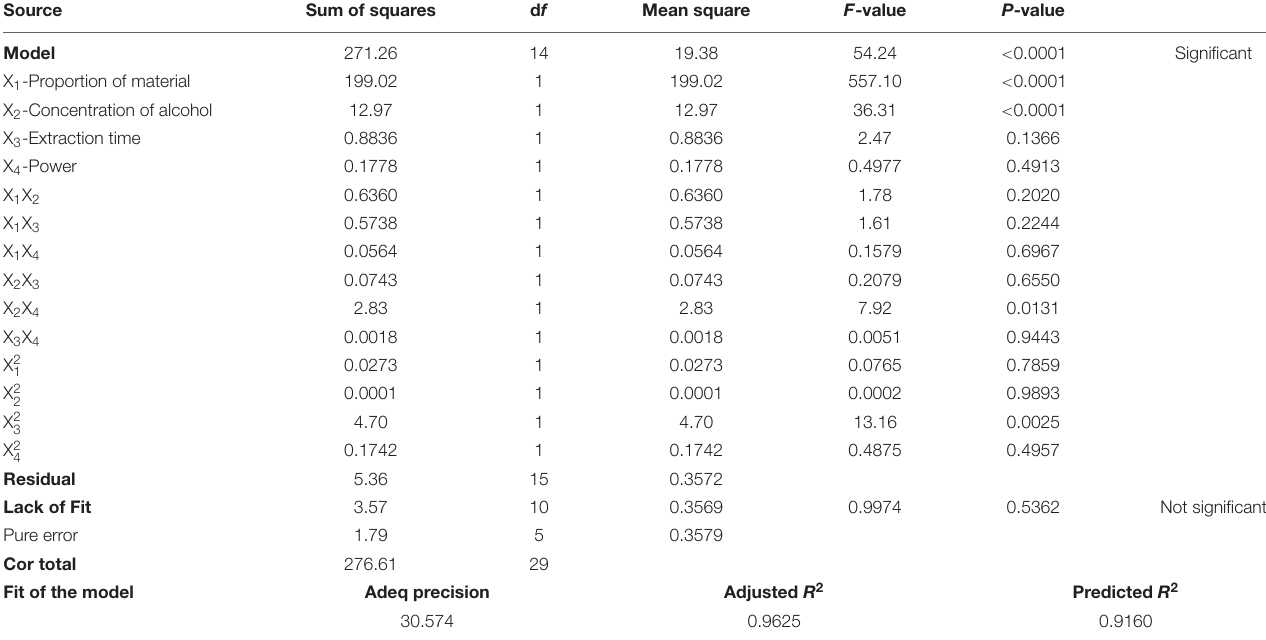
TABLE 2 | Analysis of variances (ANOVA) for the quadratic model.